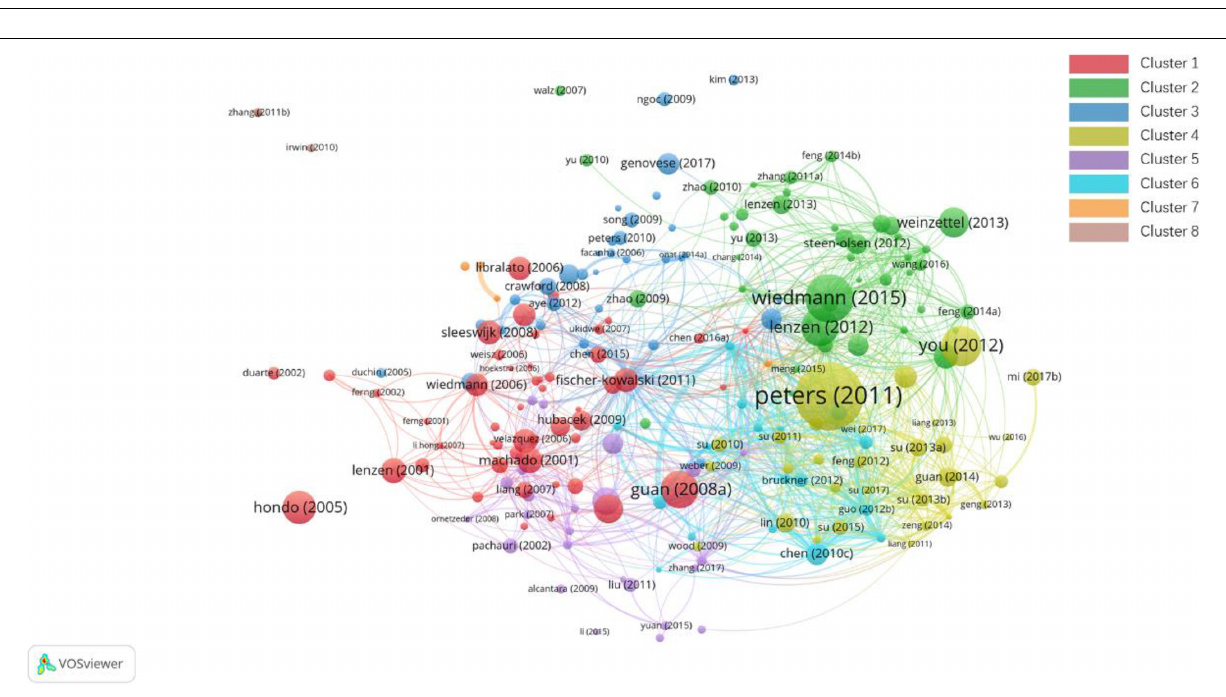
FIGURE 2 | Nations’ collaboration. The color bar represents the average year of publication of national articles.